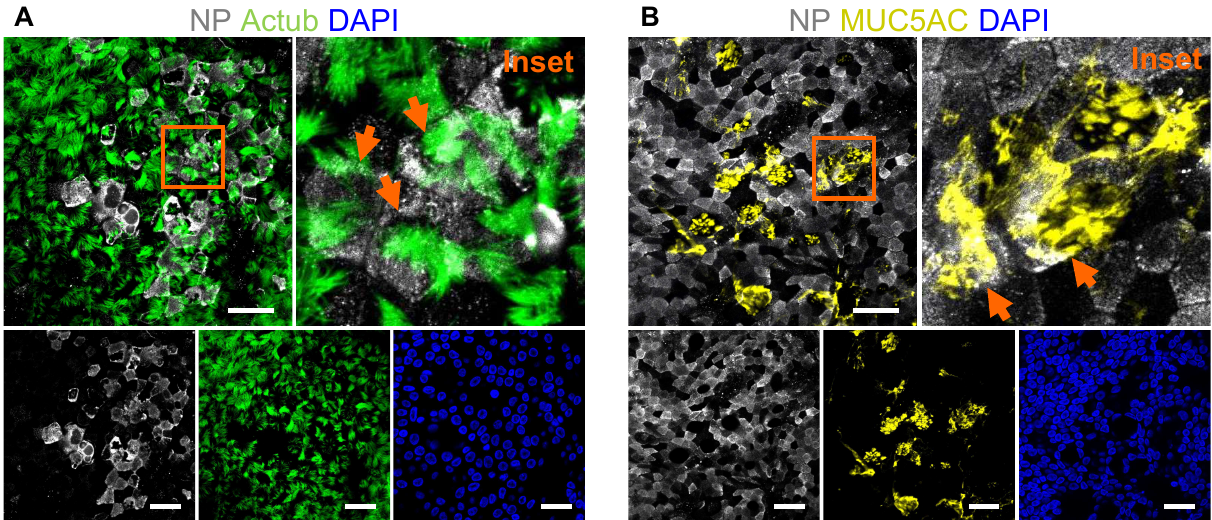
Figure 3. Visualisation of pathogen tropism in air-liquid interface cultures. Figure 3. Visualization of pathogen tropism in air-liquid interface cultures. Representative confocal images of SARS nucleocapsid protein (NP) in SARS-CoV-2-infected air-liquid interface (ALI) cultures Representative confocal images of SARS nucleocapsid protein (NP) in SARS- co-stained with ( A ) acetylated tubulin (actub, ciliated cells) and ( B ) MUC5AC (secretory goblet cells). CoV-2-infected air-liquid interface (ALI) cultures co-stained with (A) acetylated Magnified insets show NP-positive ciliated and goblet cells (orange arrows). A 63 × /1.4 objective. tubulin (actub, ciliated cells) and (B) MUC5AC (secretory goblet cells). Scale bars: 20 µ Magnified insets show NP-positive ciliated and goblet cells (orange arrows). 63x/1.4 objective. Scale bars: 20 µm.